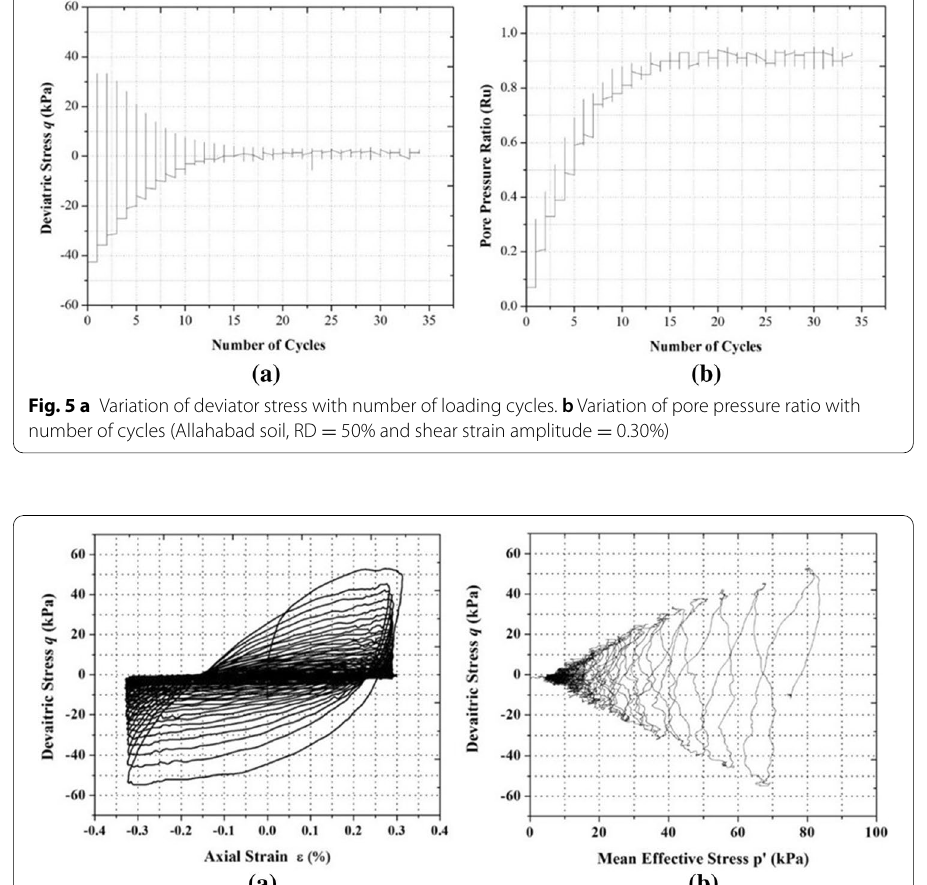
50%, effective confining pressure =